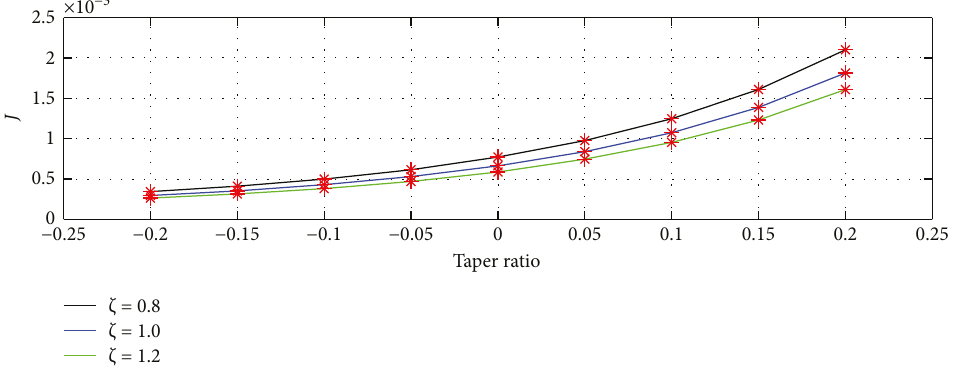
Figure 2: E ff ect of both blade root chord length and blade taper on control e ff ort for 40-knot straight-and-level fl ight condition (taken from